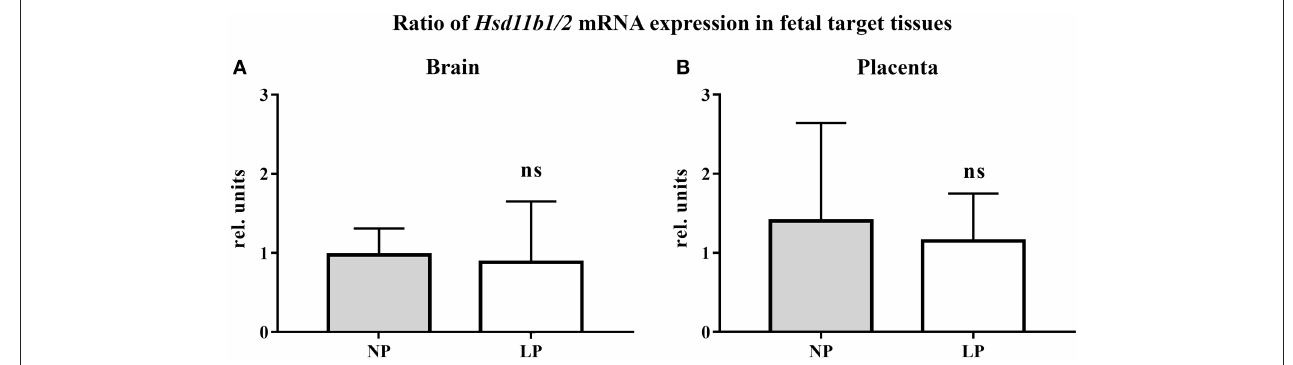
TABLE 3 | Steroid analysis of maternal whole blood. Steroids in maternal whole blood (nmol/l) n Corticosterone (Cort) Dehydrocorticosterone (DH-Cort) 91.21 ± 25.23